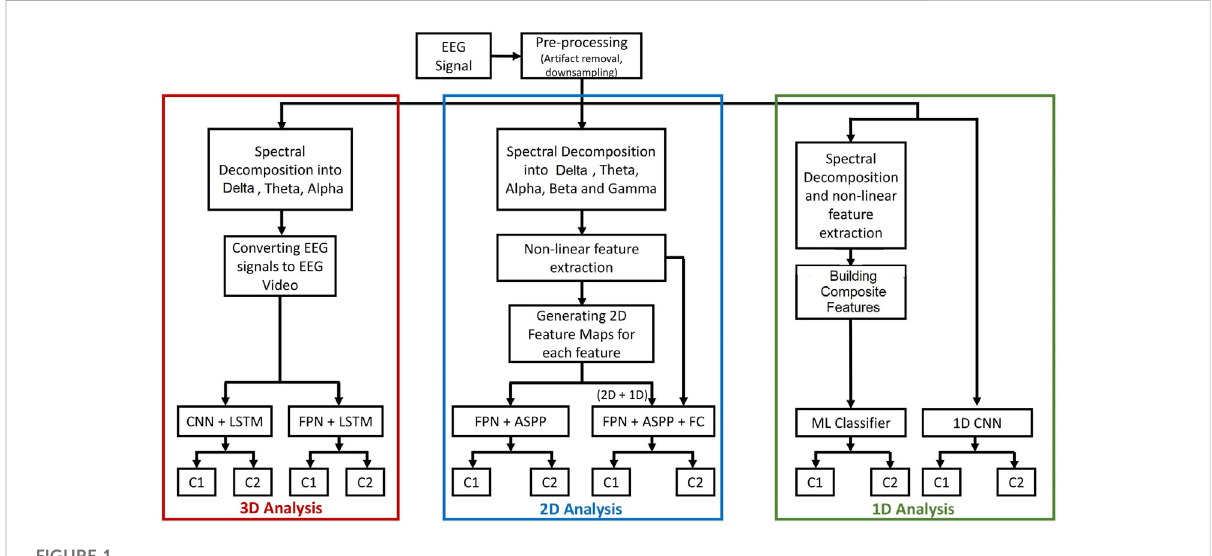
FIGURE 1 The proposed methodology for the analyzes of EEG using 1D, 2D, and 3D representations. In the 3D analysis, EEG signals are converted to videos and classi fi ed using: 1) the CNN and LSTM model or 2) the FPN and LSTM model. In the 2D analysis, feature maps are generated from hand- crafted features and classi fi ed using FPN and ASPP while a composite feature set consisting of 2D feature maps and 1D feature vector is classi fi ed using FPN and ASPP along with a fully connected classi fi cation layer. In the 1D analysis, 1D feature vectors are classi fi ed using traditional methods and raw EEG signals are analyzed using CNN.